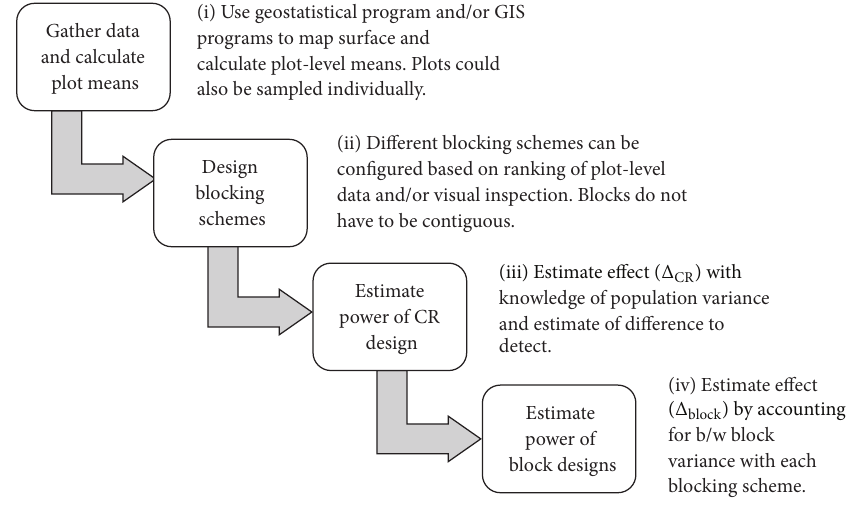
Figure 2: Diagram of process used to gather preliminary data, portray spatial variability in subplots, and analyze power of different blocking